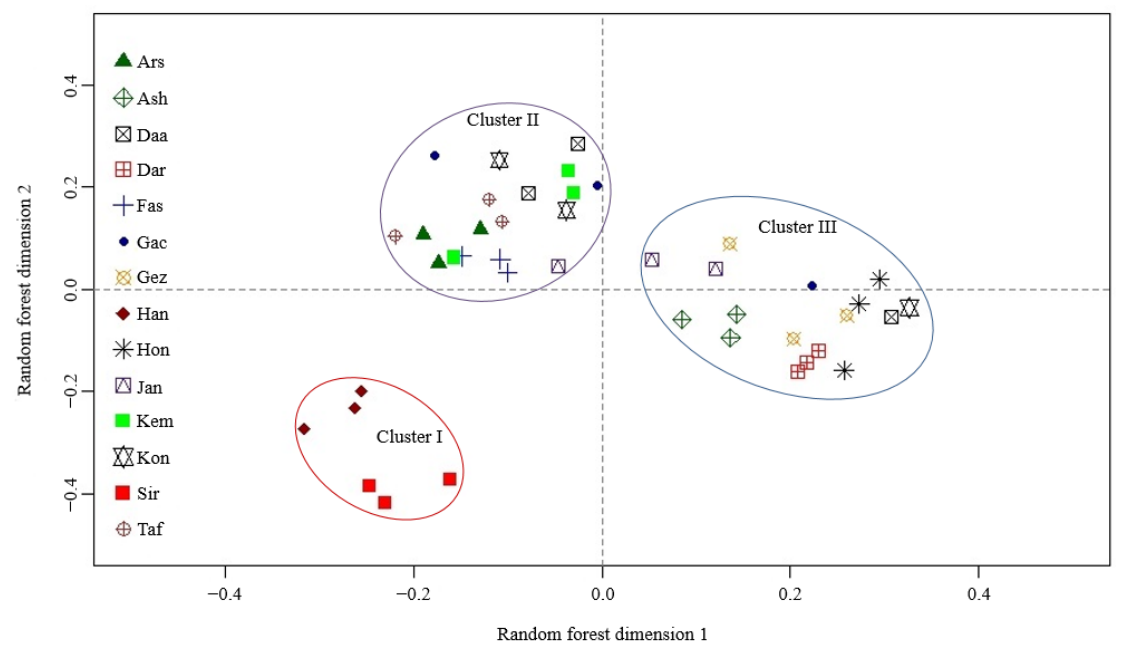
Figure 1. Unsupervised random forest classification of metabolite profiles obtained from hydroethano- lic Z. multiflora leaf extracts (14 populations × 3 samples) by reversed-phase UHPLC/DAD/ESI- QTOFMS operated in positive ion mode. The scatter plot obtained by multidimensional scaling of the proximity matrix is shown.